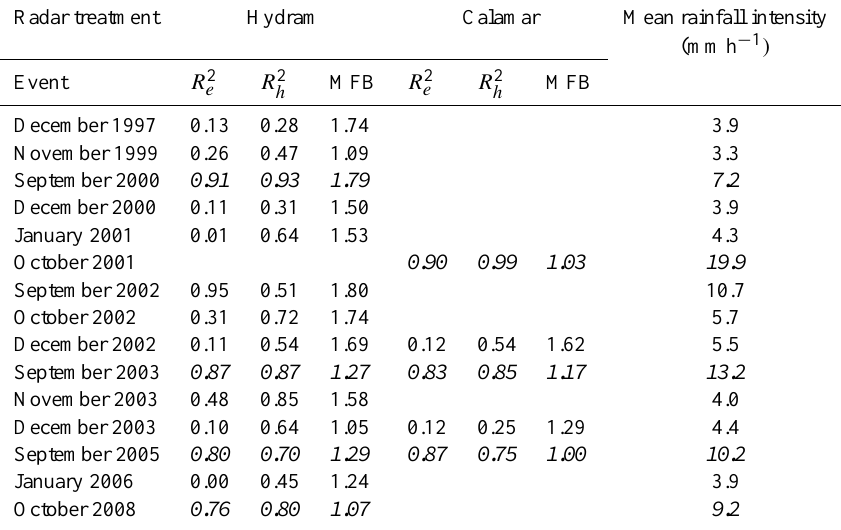
Table 2. Determination coefficients of the linear regressions between rain gauges and radar depth and Mean Field Bias (MFB) values for each rainfall radar event.